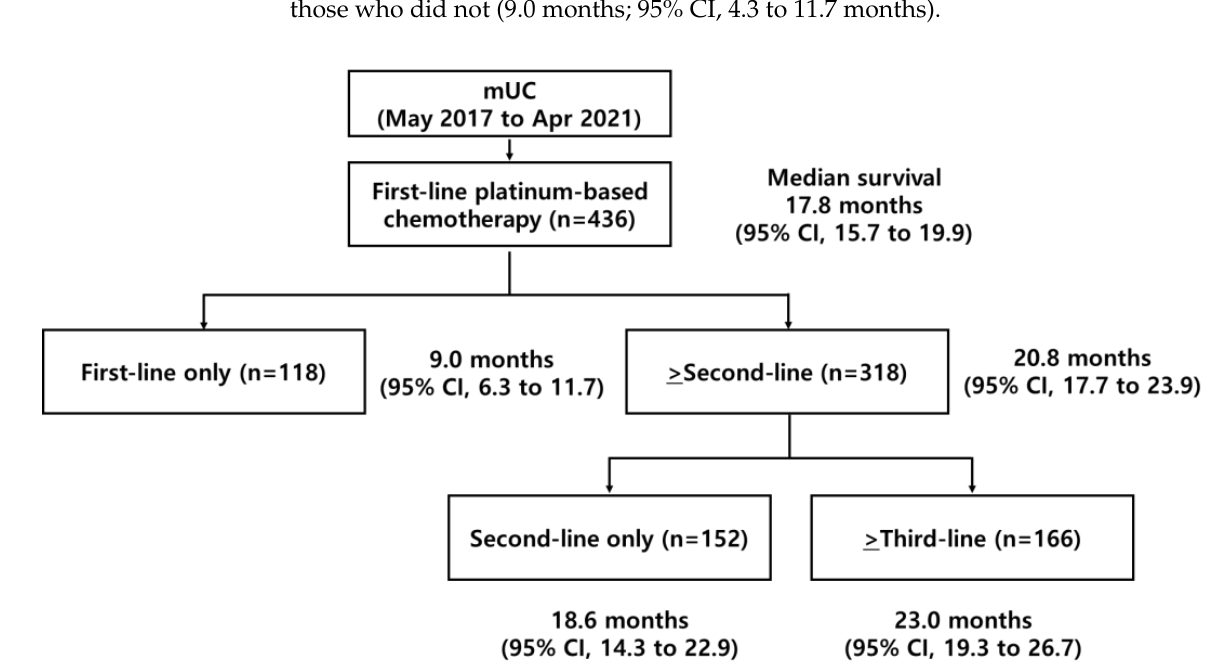
Figure 1. Diagram and median overall survivals for patients with metastatic urothelial carcinoma (mUC) treated between May 2017 and April 2021.